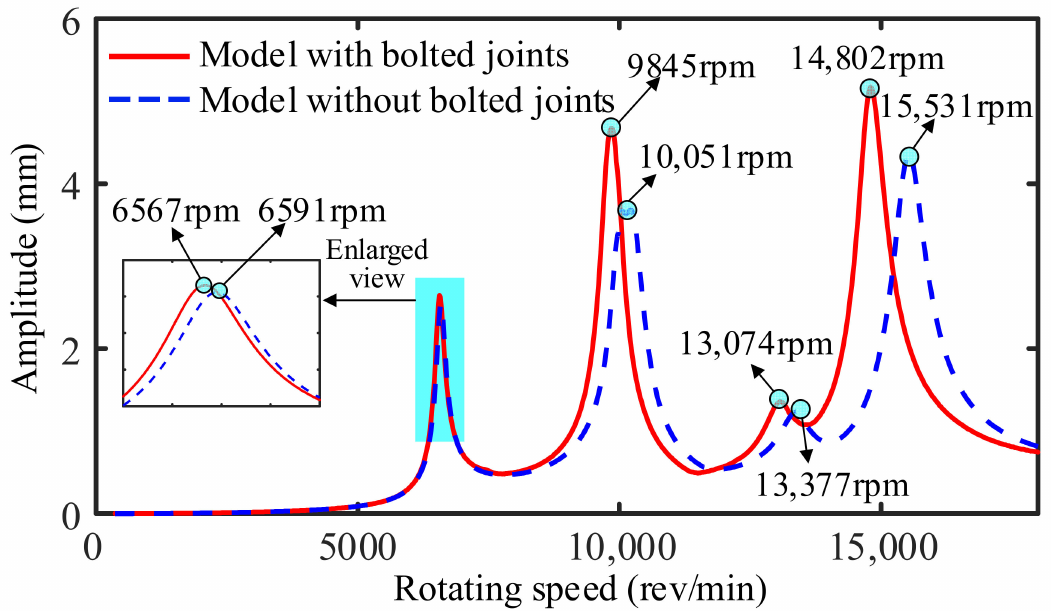
Figure 6. Comparison of the amplitude frequency responses between the models with and without bolted joints.